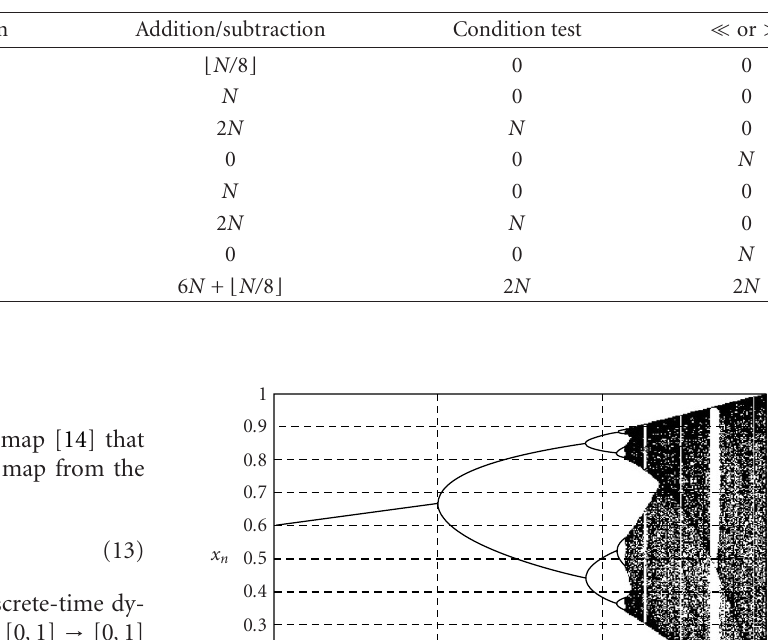
Table 1: The complexity of the proposed TDCEA on a signal of length N .